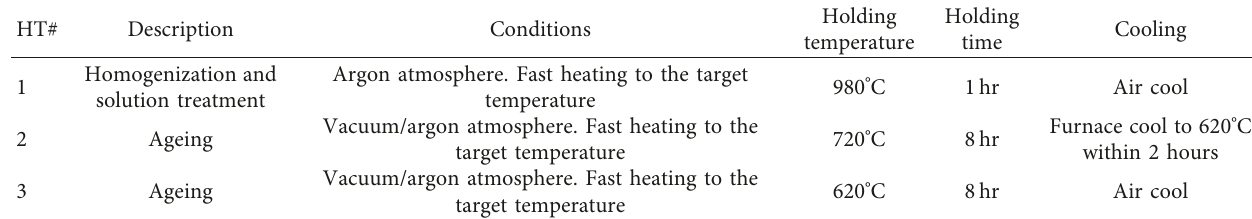
Table 5: Set 2: instructions for treatment (S + A).